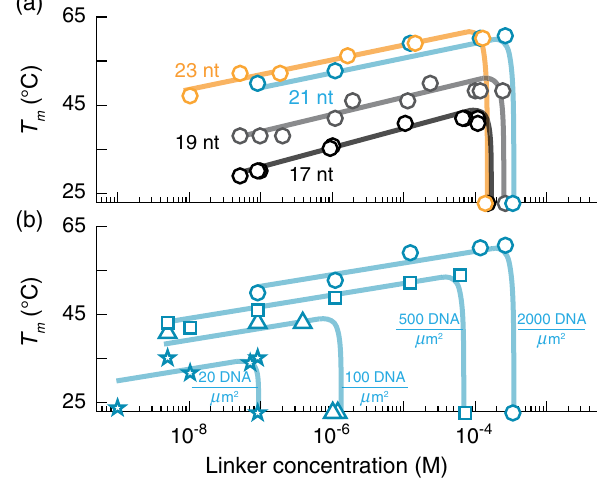
FIG. 3. Effects of linker affinity and grafting density on the phase behavior. (a) Experimental measurements of the melting temperature as a function of the linker concentration for four linkers having different lengths n : 17 nt (black), 19 nt (gray), 21 nt (blue), 23 nt (orange). All linkers are symmetric and ð n − 1 Þ = 2 bases of each linker are complementary to each grafted strand. (b) Measurements of the melting temperature as a function of the concentration for the 21-nt linker for four different grafting densities: 2000 (circles), 500 (squares), 100 (upward triangles), and 20 (stars) DNA strands per μ m 2 . The grafting densities of A and B are equal to one another. The reentrant concentrations are shown as points intersecting the linker-concentration axis and have a precision of roughly a factor of 2. Lines in (a) and (b) are guides to the